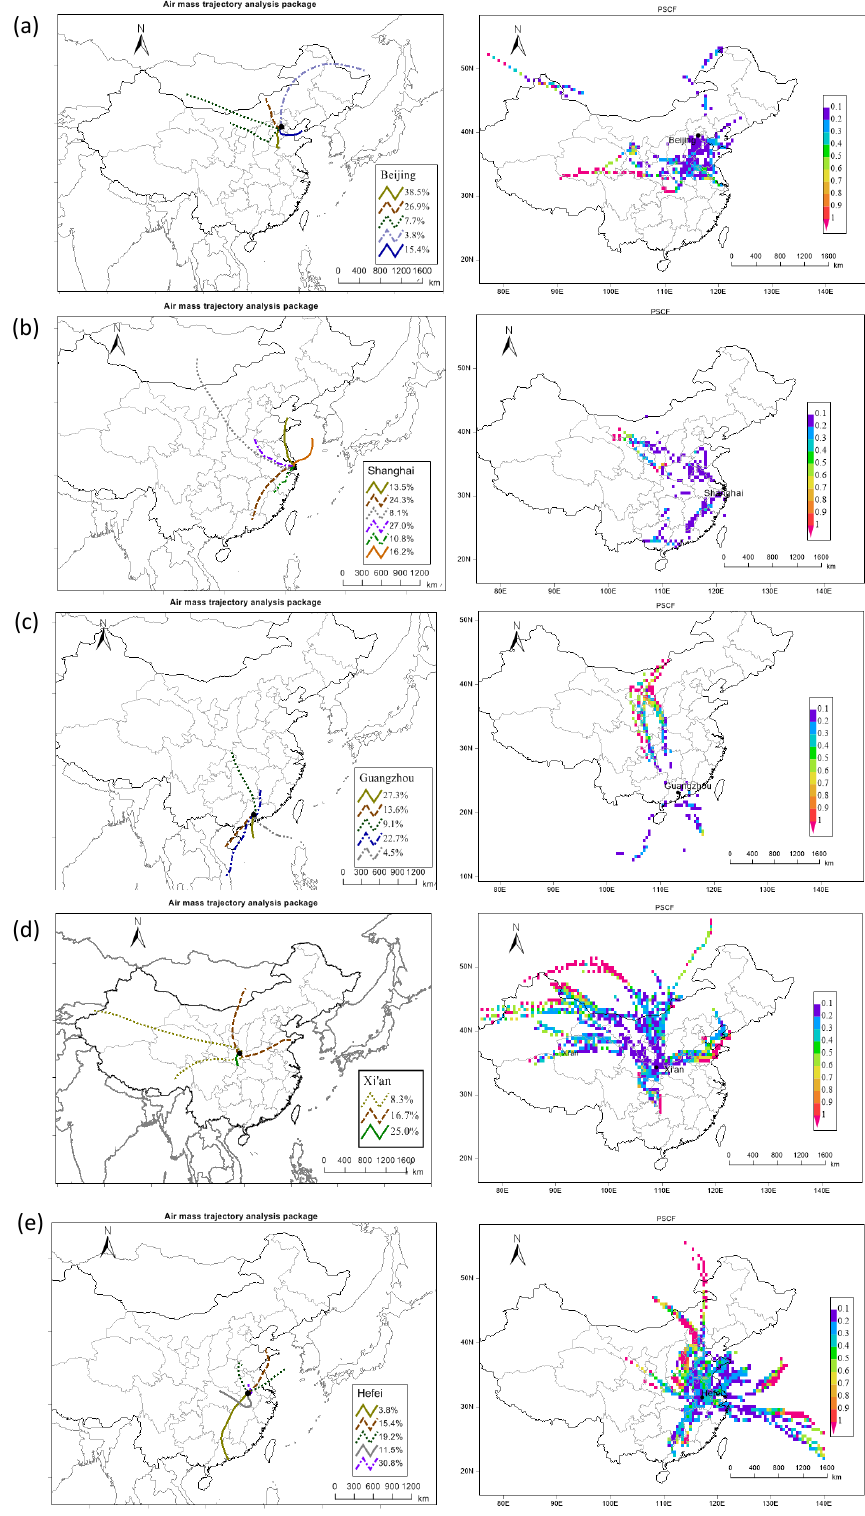
Figure 7. 48 h air mass back-trajectory during O 3 episodes. The left column is the clustering analysis with an 8-h O 3 concentrations exceeding 160 µg m −3 ; the right column is the PSCF with hourly O 3 concentrations exceeding 200 µg m −3 in Beijing ( a ), Shanghai ( b ) and Guangzhou ( c ), and hourly O 3 concentrations exceeding 160 µg m −3 in Xi′an ( d ) and Hefei ( e ).